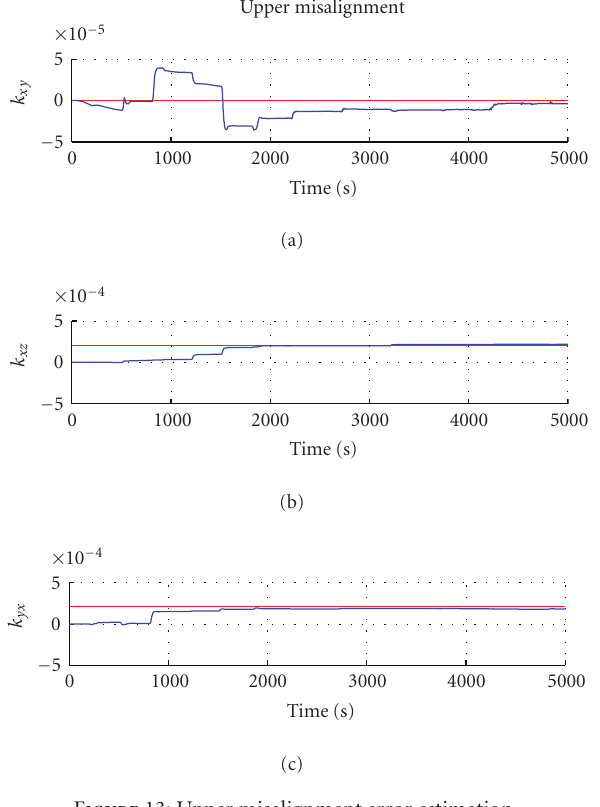
Figure 13: Upper misalignment error estimation.